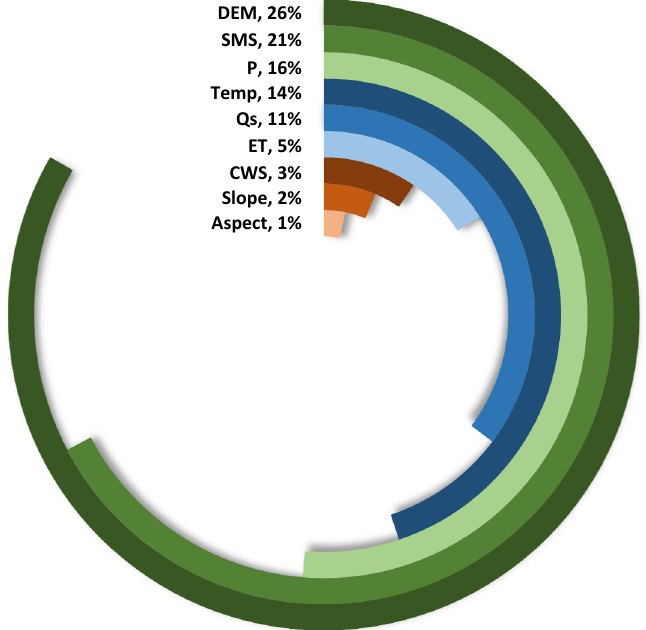
12 of 30 Figure 3. Illustration of machine learning models accuracy in one-one graphs. The dashed black line shows the one-one line and the dashed red line shows the linear trend line. 4.2. Sensitivity Analysis of the XGBoost Model The significance of the independent variables was further examined in light of the regression model, which evaluated the independent variables’ capacity for prediction. The XGBoost-based model’s ranking of the relevance of independent variables is shown